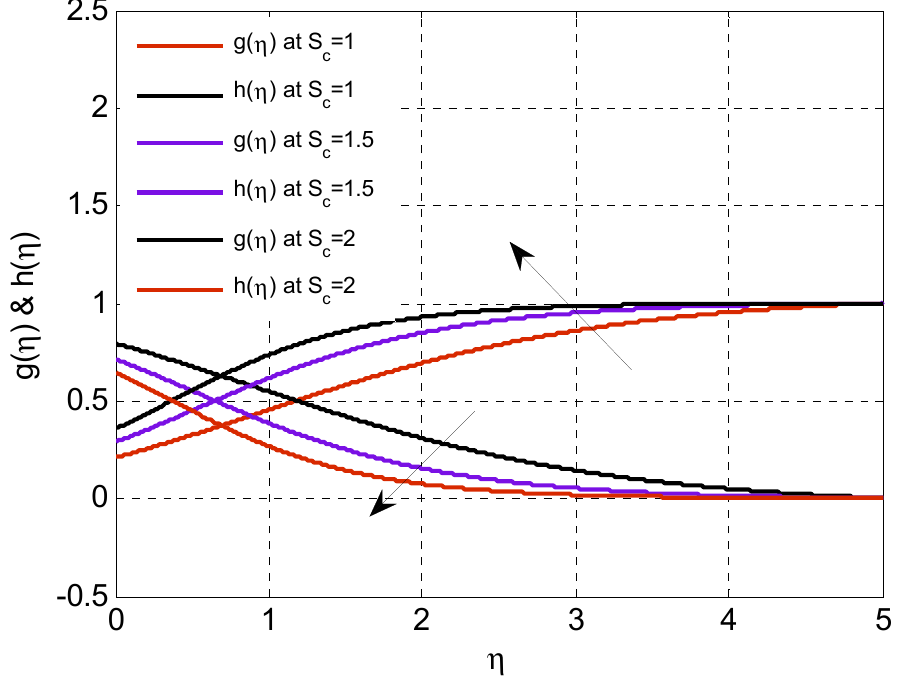
Figure 12. Effect of Schmidt number on concentration profiles of species A and B using G = 1, K b = 1, λ = 0.5, F r = 0.1, K = 1, δ = 1, K 2 = 1, and N = 3040.